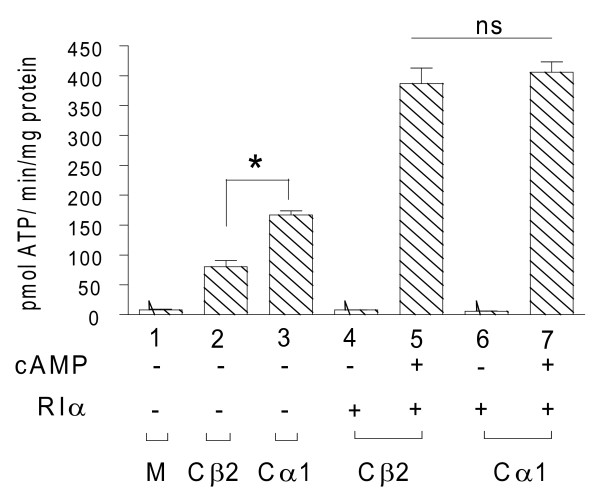
Cα1 and Cβ2 proteins are stabilized by RIα. 293T cells were untransfected (M) or transfected with fixed amounts of either pDeCα1 (300 ng) or pDeCβ2 (1400 ng) in conjunction with 1280 ng (bars 4 to 7) or without (bars 1-3) pDeRIα for 24 h. Cell extracts were adjusted to 1 mg total protein/mL and assayed for PKA-specific phosphotransferase activity in the absence (- cAMP) and presence (+ cAMP) of 320 nM cAMP. Data points represent pmol ATP transferred/min/mg protein) +/- SD (n = 3). The relative activities of Cβ2 and Cα1 in the absence of RIα were significantly different (* p < 0.02, bars 2 and 3). When Cα1 and Cβ2 were co-transfected with RIα the relative activities were indistinguishable (bars 5 and 7, ns).